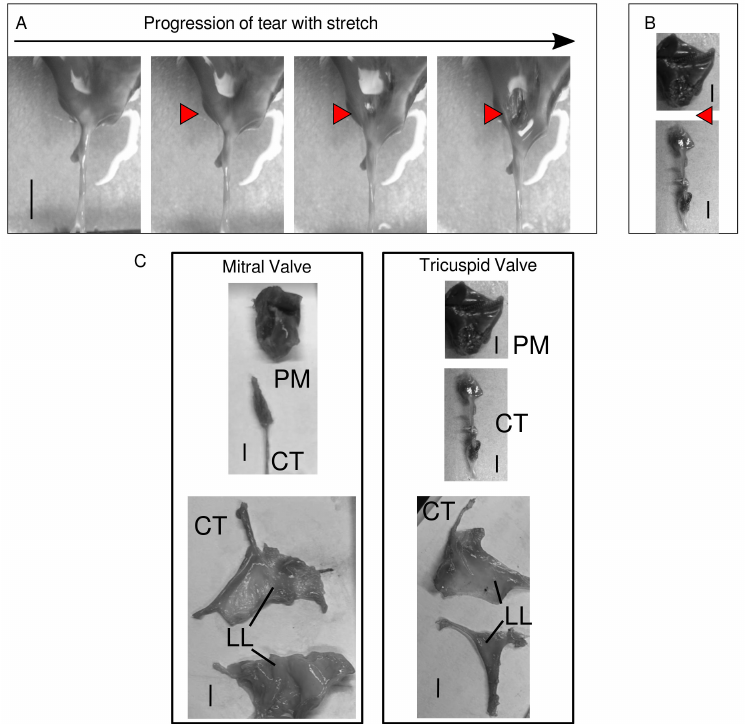
Figure 6. ( A ) Tear in the PM–CT junction of the TV. The red arrowheads show the beginning and progression of the tear in the sample with stretch. ( B ) shows a picture of a torn sample and the point of detachment. ( C ) Post-tear. Note in ( B ) and ( C ), the PM–CT sample from TV were recorded in one image that was modified to place the PM and CT elements closer together for direct comparison to MV image. The sample itself was not modified in the image. Scale bar in all panels shows 5